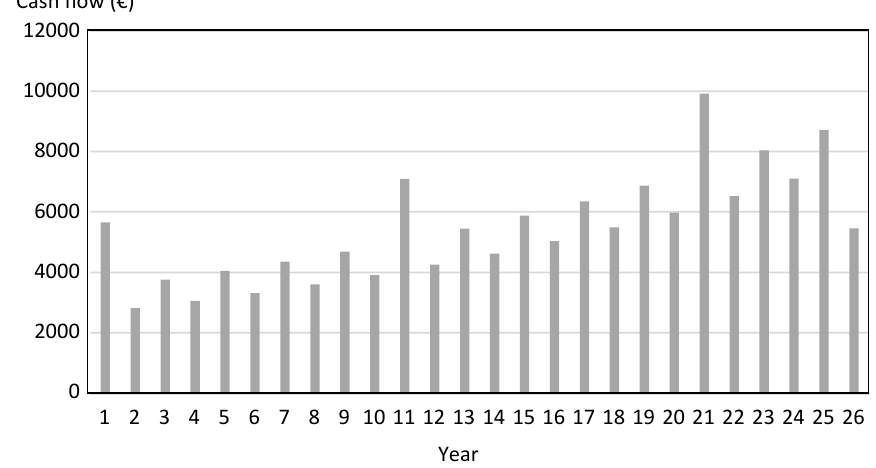
Figure 5. Cash flow of the solar PV system with a diesel generator.